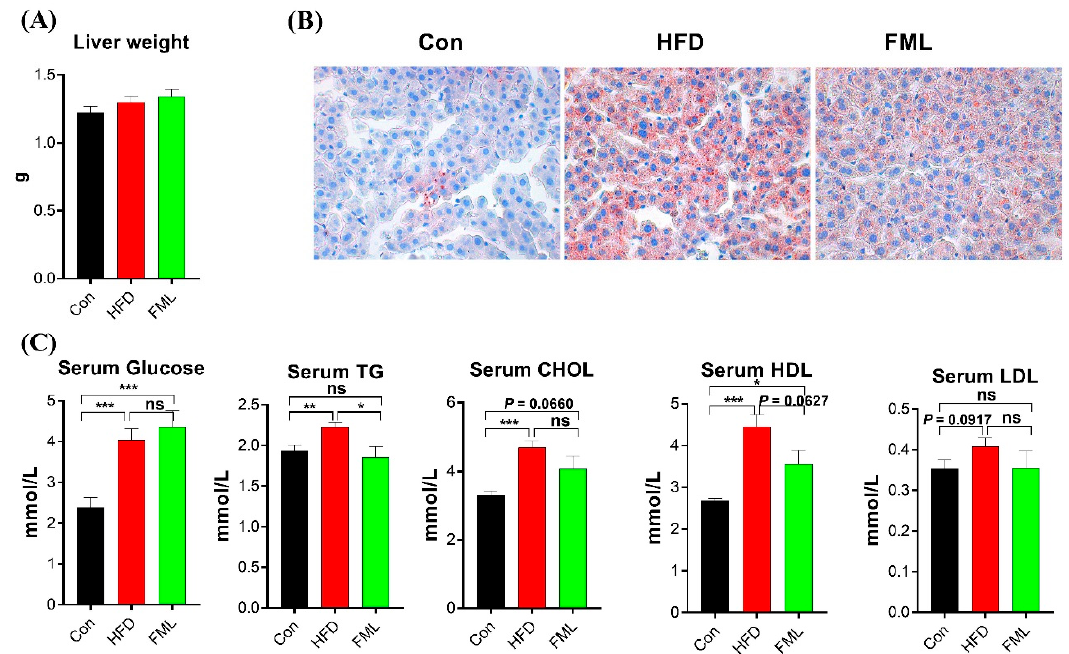
Figure 2. FML administration improved lipid metabolism in HFD-fed mice. ( A ) Liver weight, ( B ) liver oil red O staining ( × 400), ( C ) serum concentrations of glucose, triacylglycerol (TG), total cholesterol (CHOL), high density lipoprotein (HDL), and low density lipoprotein (LDL) in mice ( n = 5). Data are presented as mean ± SEM, differences were denoted as follows: * p < 0.05, ** p < 0.01, *** p < 0.001; ns p > 0.05.